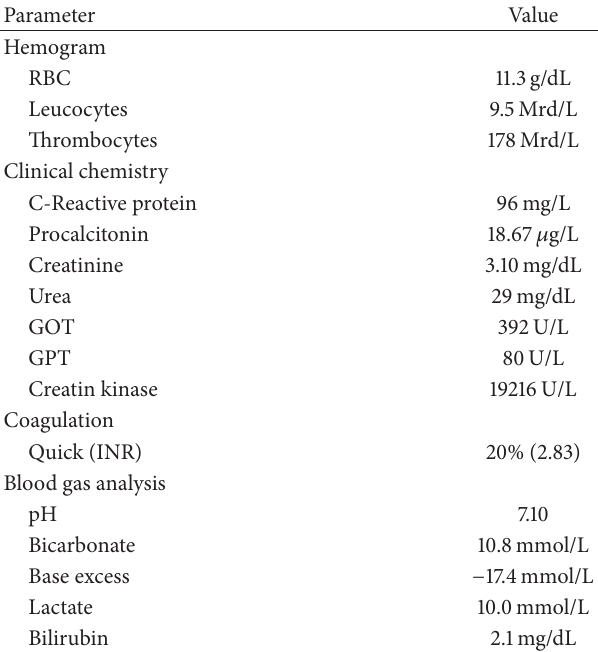
Table 1: Emergency laboratory results (selection of parameters of